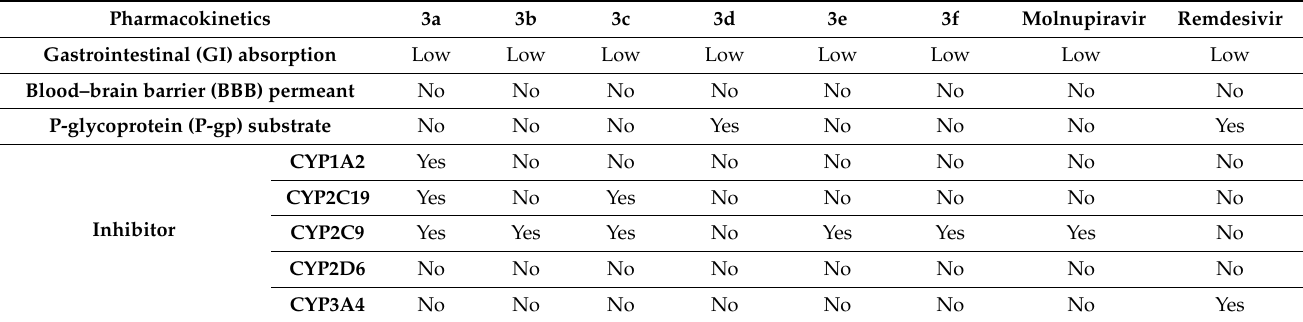
Table 6. The pharmacokinetics properties of ligands 3a–f in comparison with those of the approved drugs, Molnupiravir and